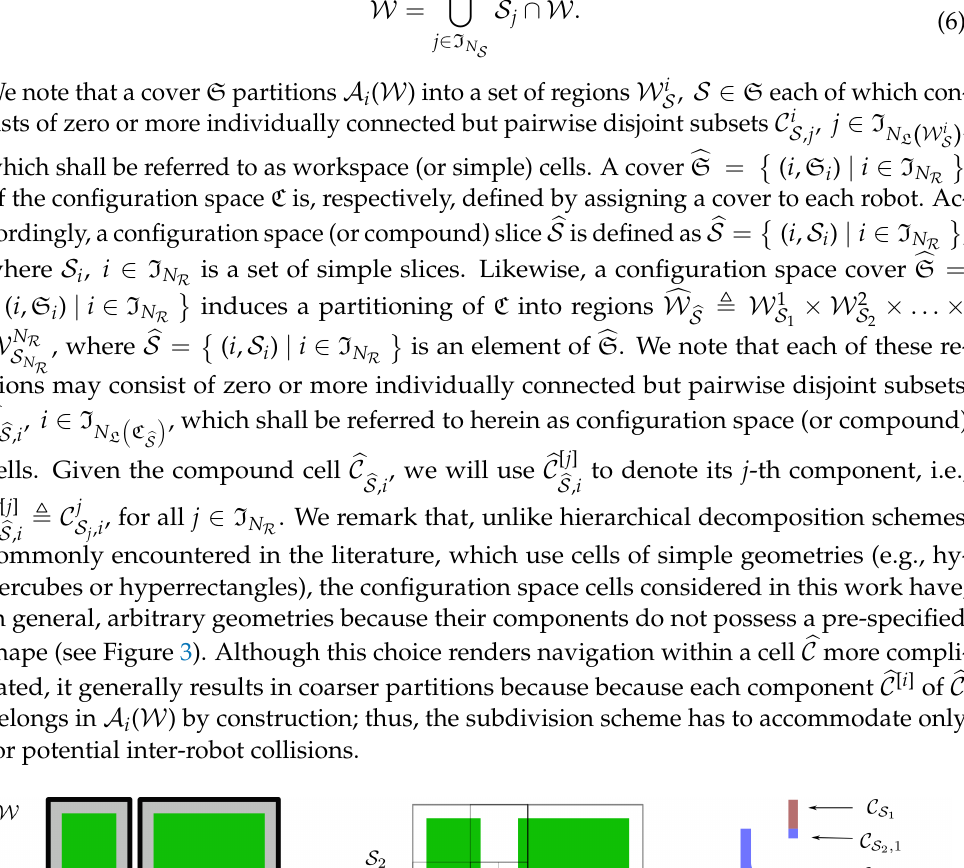
, C S ). The 2 ,1 2 ,2 and 1